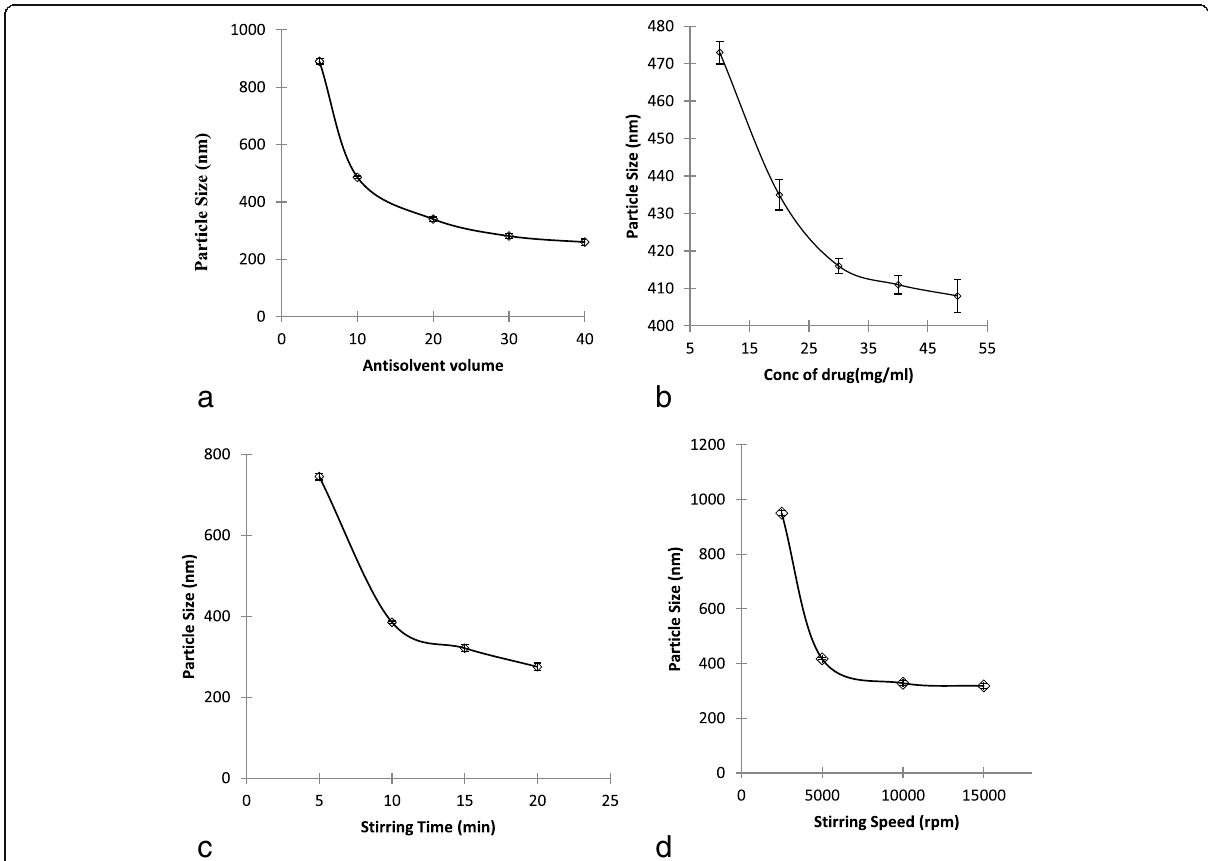
Fig. 10 Effect of a Antisolvent volume ratio, b Conc. of drug, c stirring time, and d stirring speed on particle